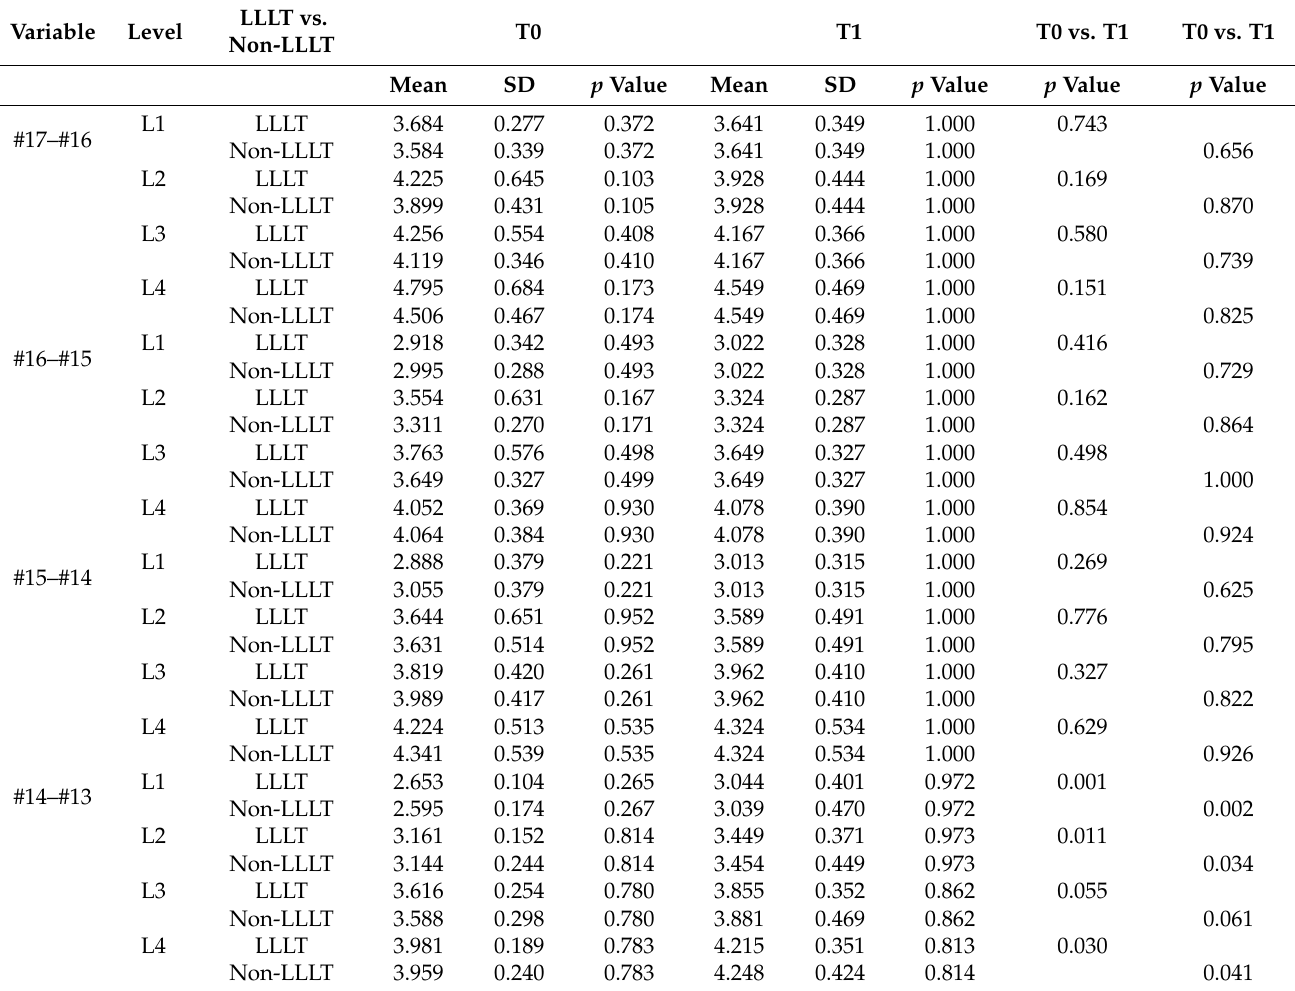
Table 3. IRW of the maxilla (both sides) at various levels. LLLT and non-LLLT differences among pre- and post-treatment groups—posterior right quadrant teeth.